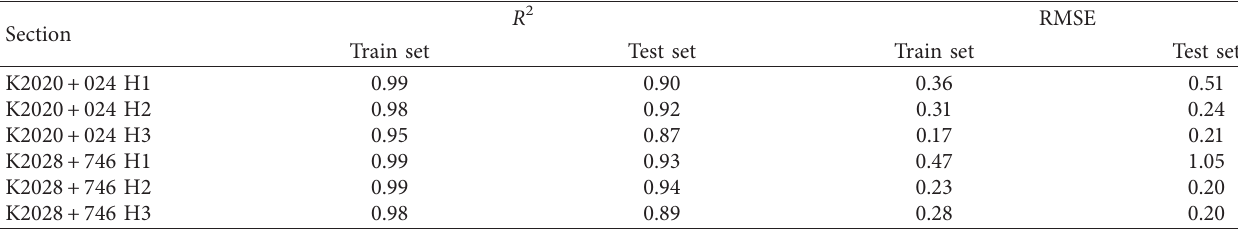
Table 1: Performance evaluation index of the